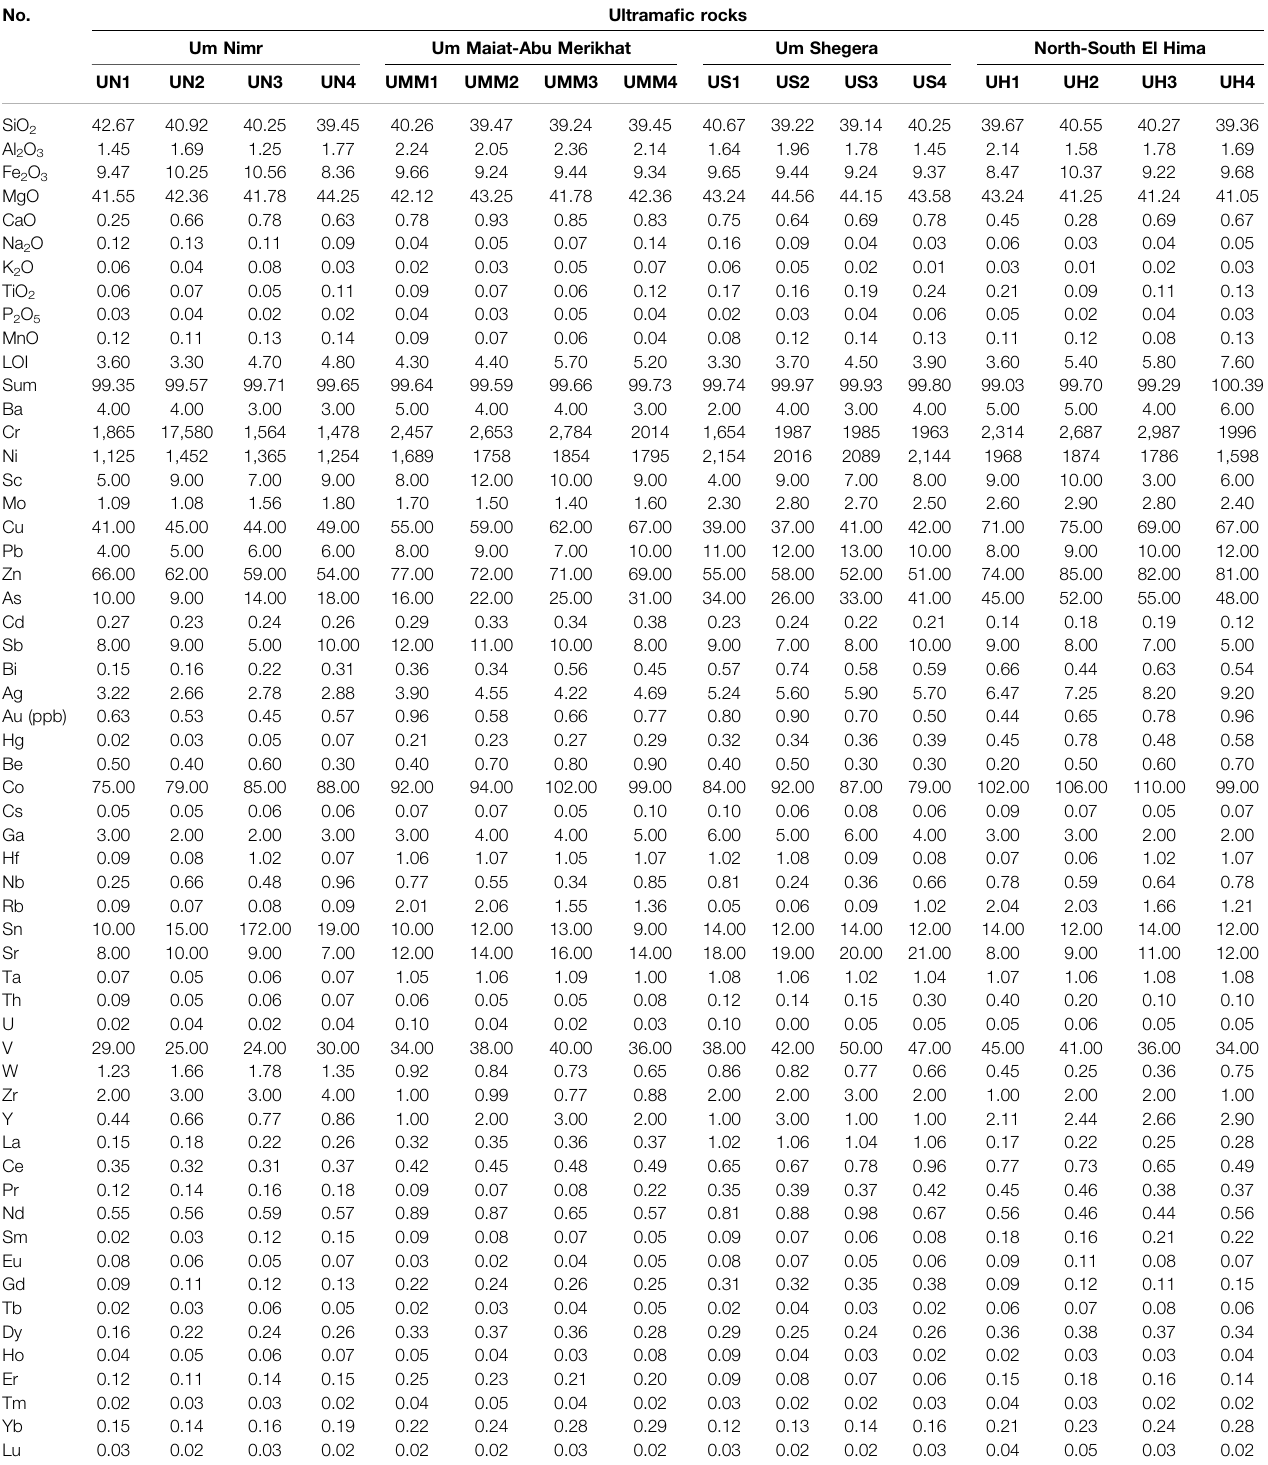
TABLE 1 | Whole rocks (major, trace, and REEs) of Um Nimr, Um Maiat-Abu Merikhat, Um Shegera, and-North-South El Hima ultrama fi c rocks.